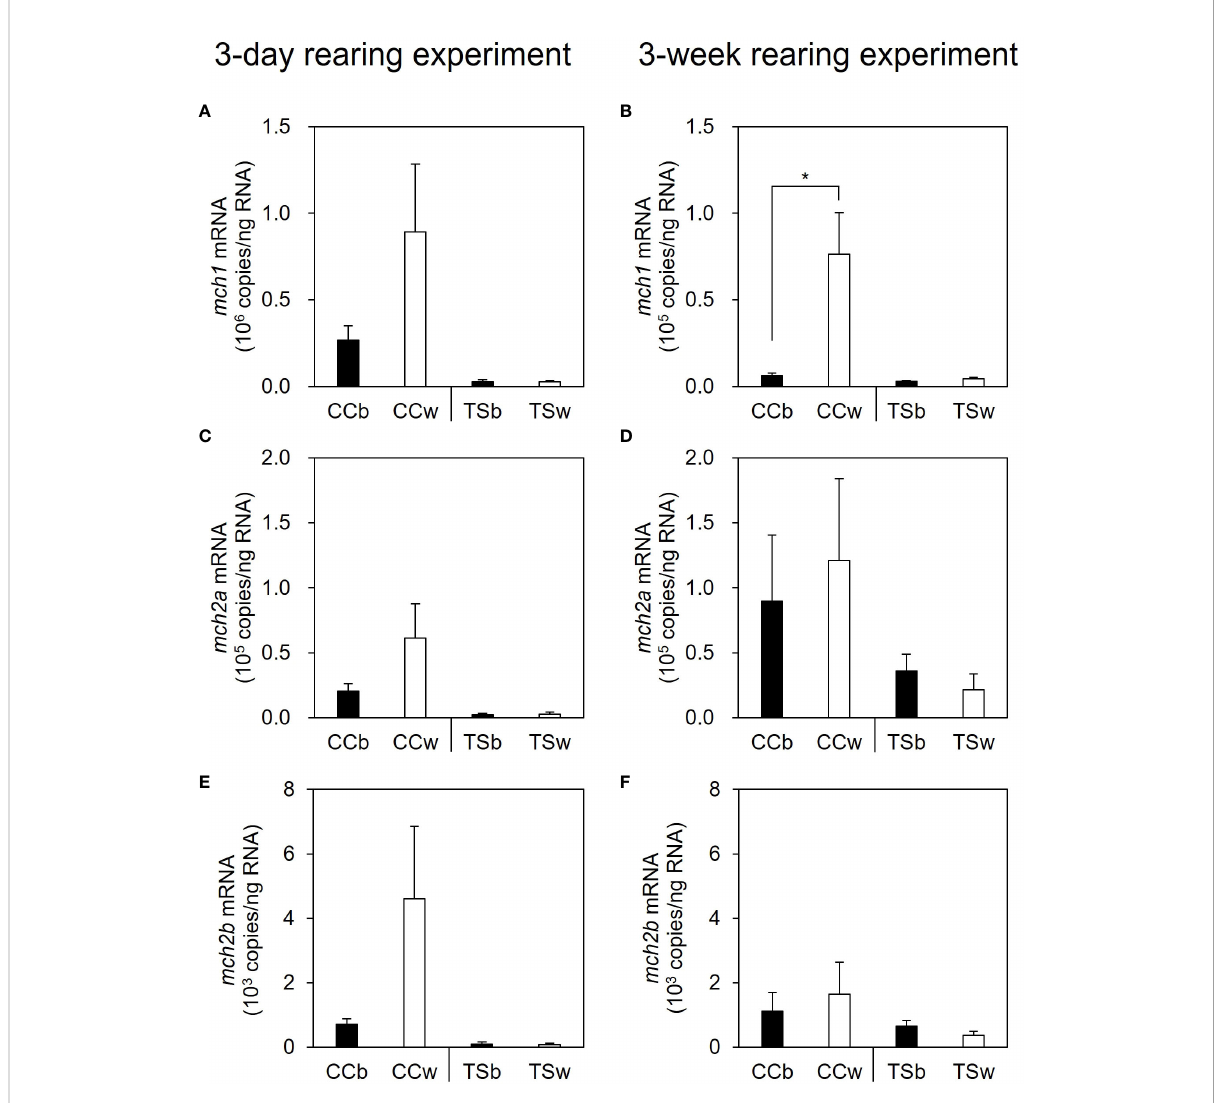
FIGURE 3 Effects of background color on the expression of melanin-concentrating hormone ( mch) mRNA in the brain. The mRNA levels of mch1 , mch2a , and mch2b in the brain in the 3-day (A, C, E) and 3-week rearing experiments (B, D, F) . Data are shown as mean ± SE. Asterisk indicates statistically signi fi cant difference estimated using the Welch test (* P < 0.05, n =